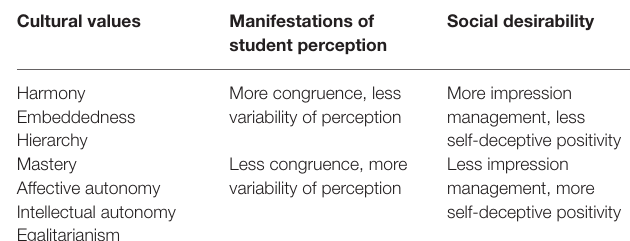
TABLE 1 | The relationship between cultural values, student perception, and social